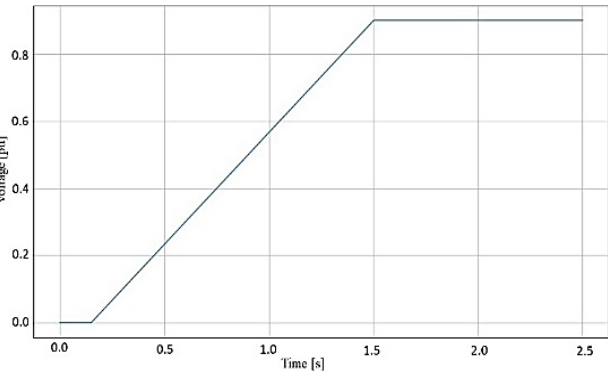
Figure 7. Fault current contribution response of IBDER connected to bus 14 during 3LG short-circuit at bus 9 in time 392 domain obtained with Typhoon HIL setup.